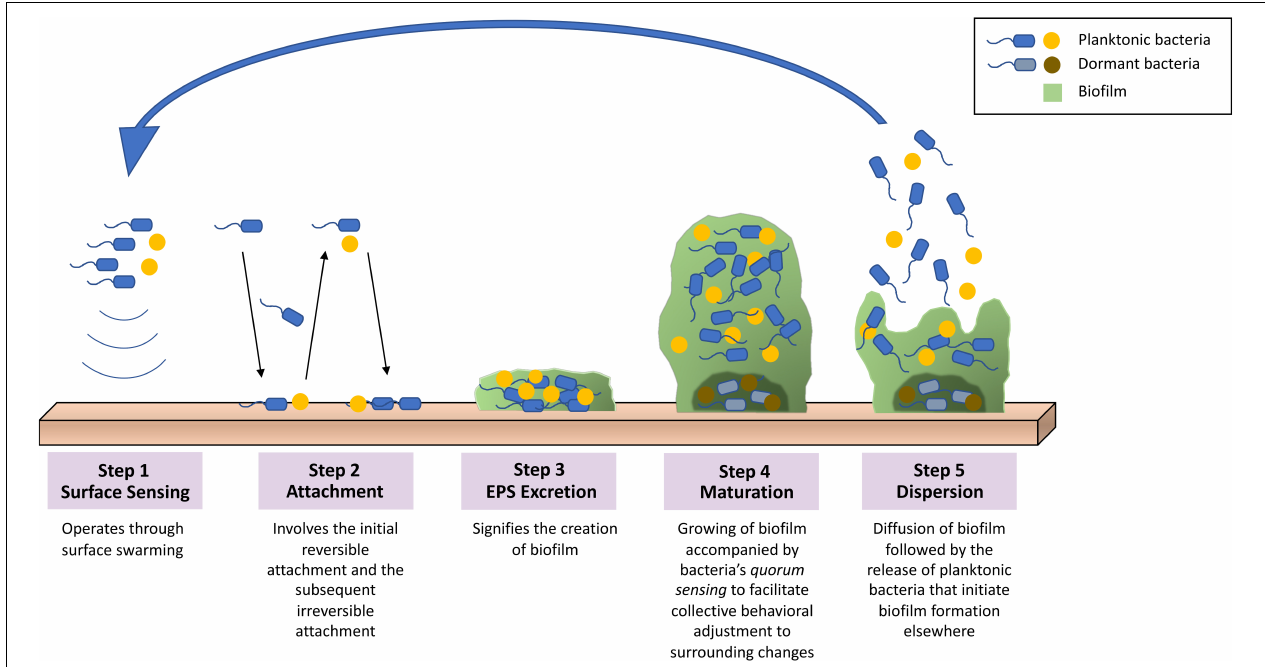
FIGURE 2 | Overview of the biofilm formation process. (1) Surface sensing operated by surface swarming. (2) Attachment stage involving the initial reversible attachment and the subsequent irreversible attachment. (3) Excretion of EPS that signifies the creation of biofilm. (4) Maturation of biofilm that involves quorum sensing to facilitate collective behavioral adjustments to surrounding changes. (5) Dispersal of biofilm structure following the release of planktonic bacteria initiating biofilm formation